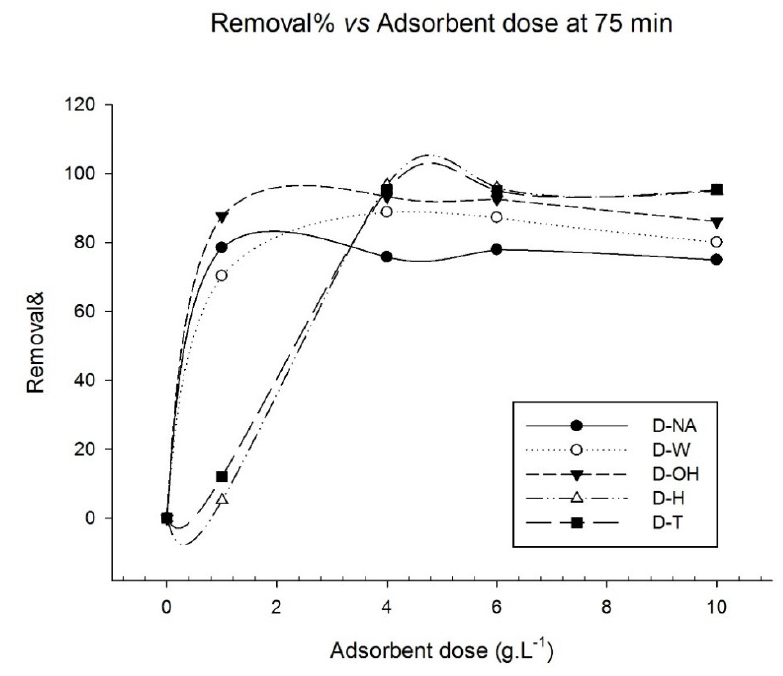
Figure 8. Effect of biomass dose of dry U. lactuca on the removal of MB.